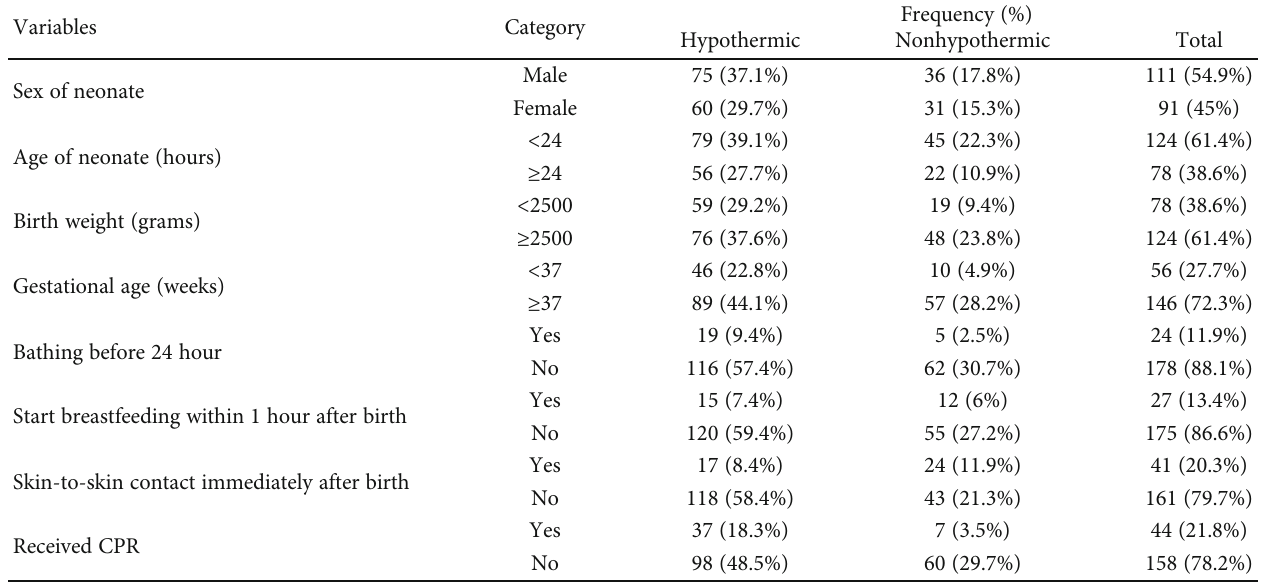
Table 2: Neonatal factors of the study participants in Dessie Referral Hospital, Northeast Ethiopia, 2018 ( N = 202